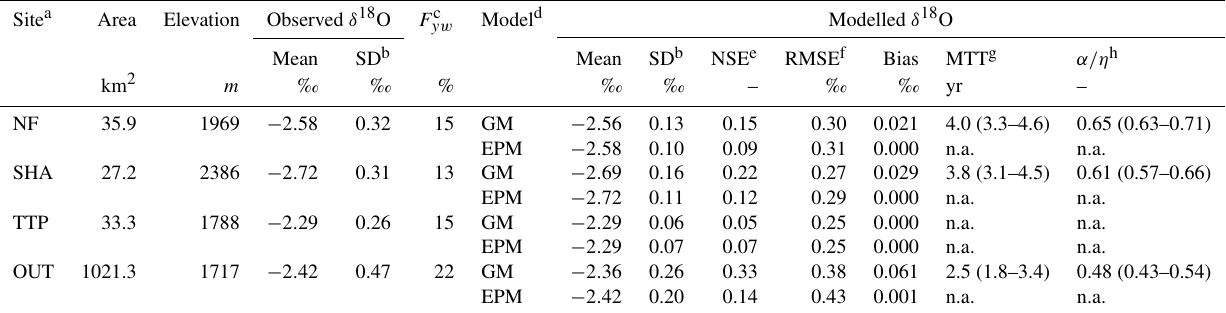
Table 5. Main statistical parameters of observed and modelled δ 18 O for stream water in the three sub-catchments and the main catchments for the gamma model (GM) and exponential piston flow model (EPM). Uncertainty bounds of the modelled parameters ( τ and α or η ), in parentheses, were calculated through generalized likelihood uncertainty estimation (GLUE).